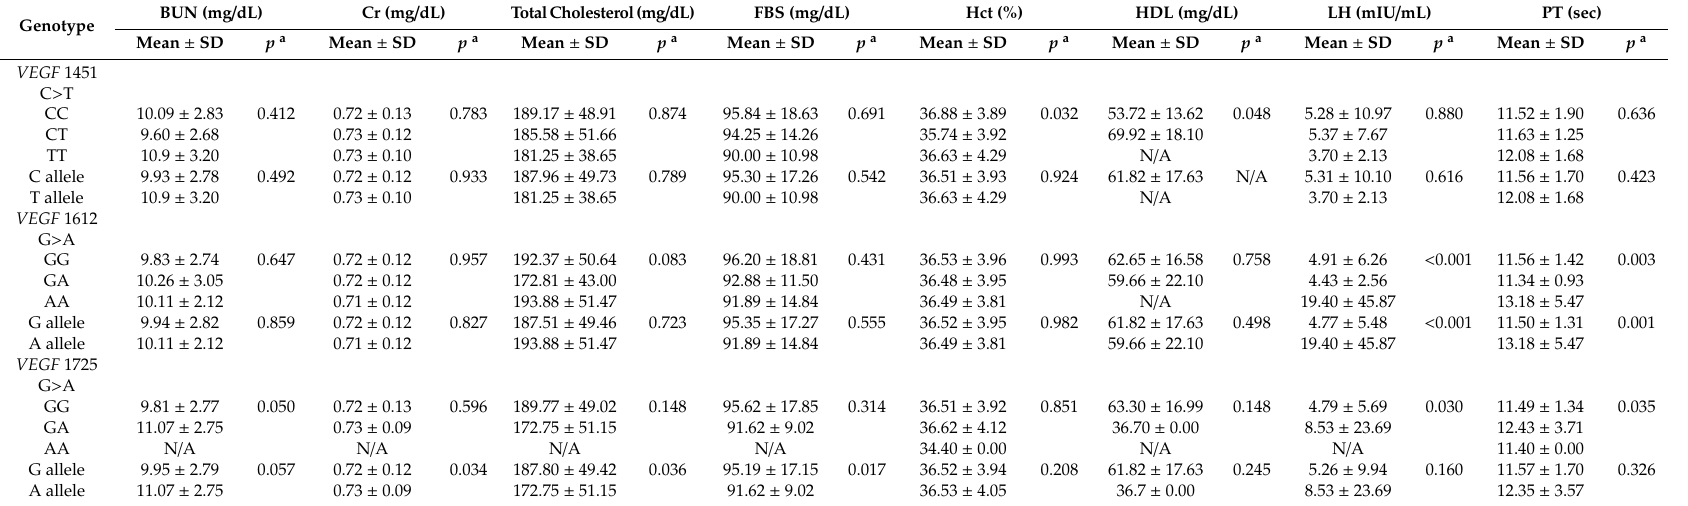
Table 6. Clinical variables in RPL patients, stratified by VEGF polymorphisms 1451C > T, 1612G > A, and 1725G > A